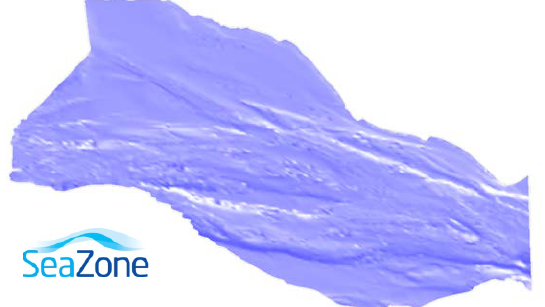
Figure 1: Bathymetric survey, containing ~58 million points. Data courtesy HR Wallingford: SeaZone.